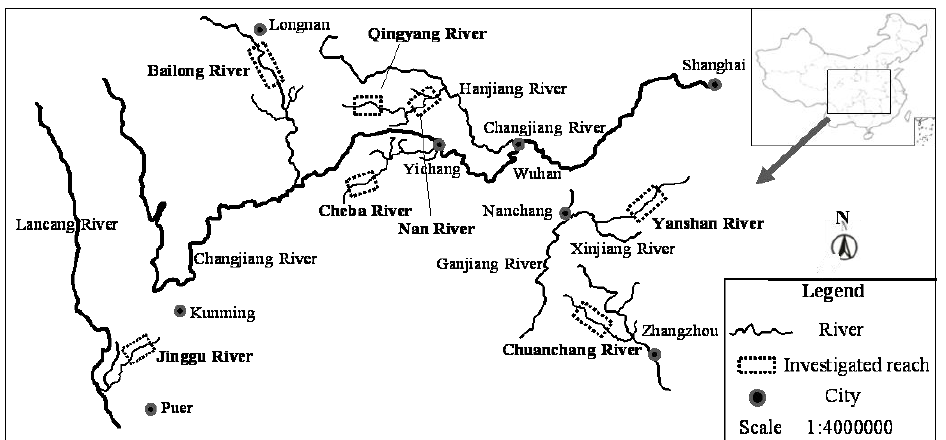
Figure 1. Schematic map of seven investigated rivers in the study (The scale is only for the Changjiang River and Lancang River. Scales of seven investigated rivers have been artificially enlarged to show their location and shape clearly).